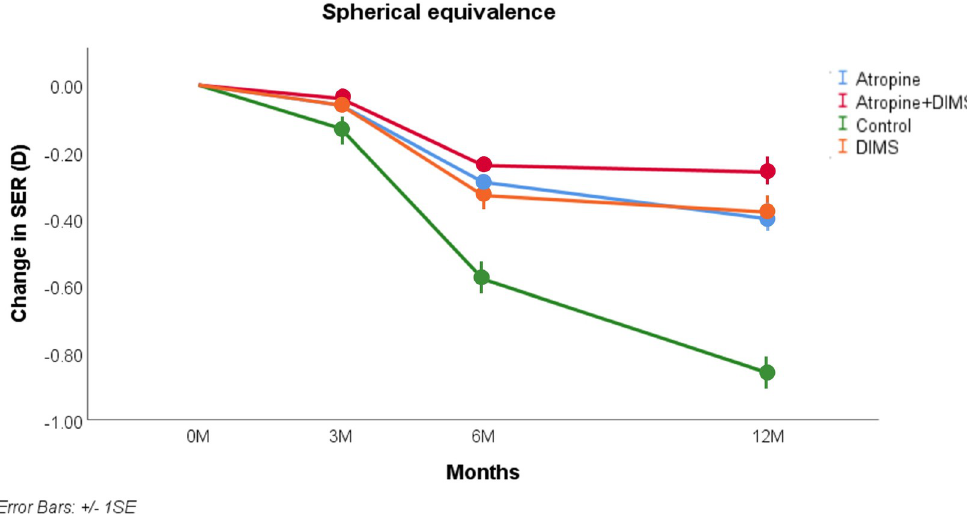
Fig 1. Model-adjusted mean and SE of myopia progression (SER) from baseline to 12